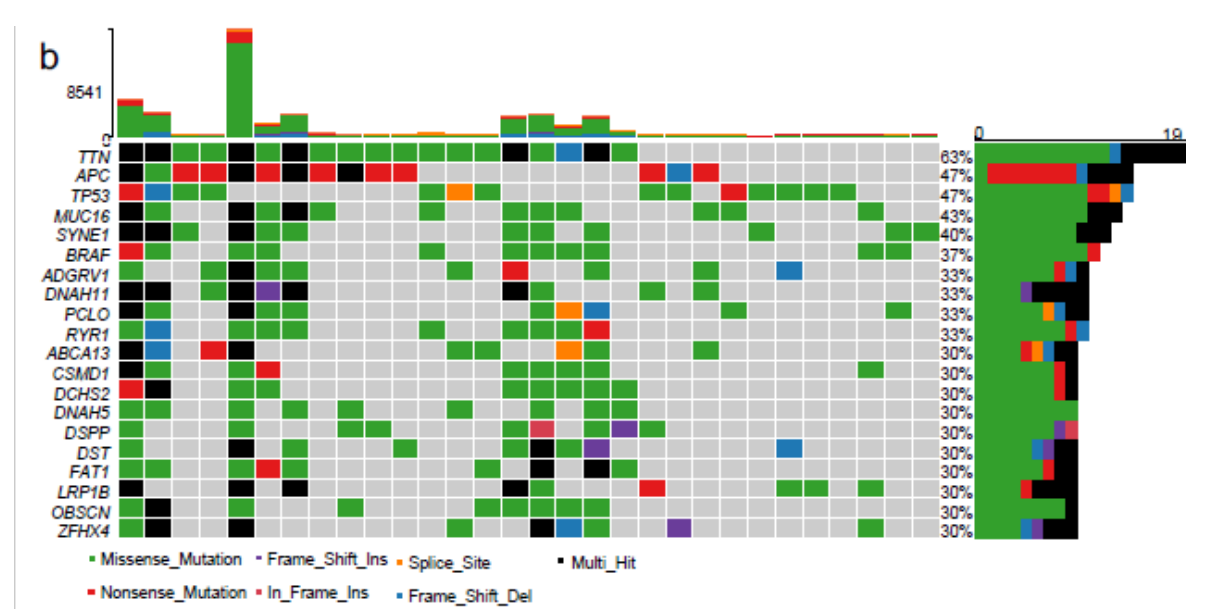
Figure 4. Oncoplot of the 20 most frequent mutations in “ not highly infiltrated ” vs. “ very highly infiltrated ” CRCs. ( a ) Top mutated genes in the “ not highly infiltrated ” ( “ low ” plus “ highly infiltrated) CRCs. ( b ) Top mutated genes in the “ very highly ” infiltrated CRCs. The upper chart of the diagrams represents the number of hits for every single patient. On the left are the genes ’ names; the grid represents the gene status for every patient (the colour code for the alteration subtypes is in the legend on the bottom); on the right, the percentual frequency and the absolute number of each gene alteration.